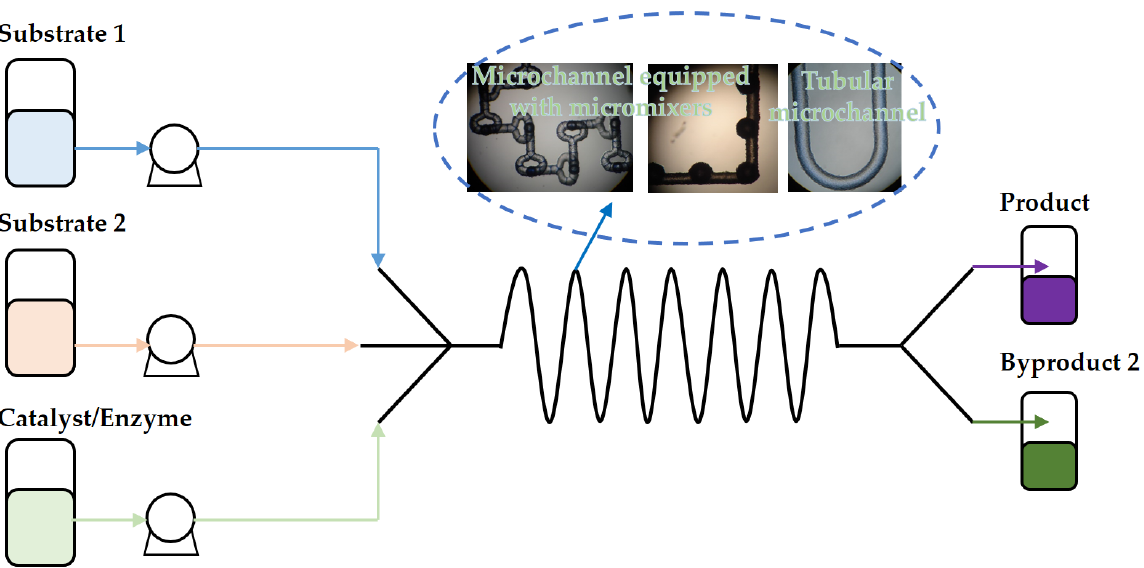
Figure 1. Simplified schematic presentation of microreactor Figure 1. Simpli fi ed schematic presentation of microreactor system.